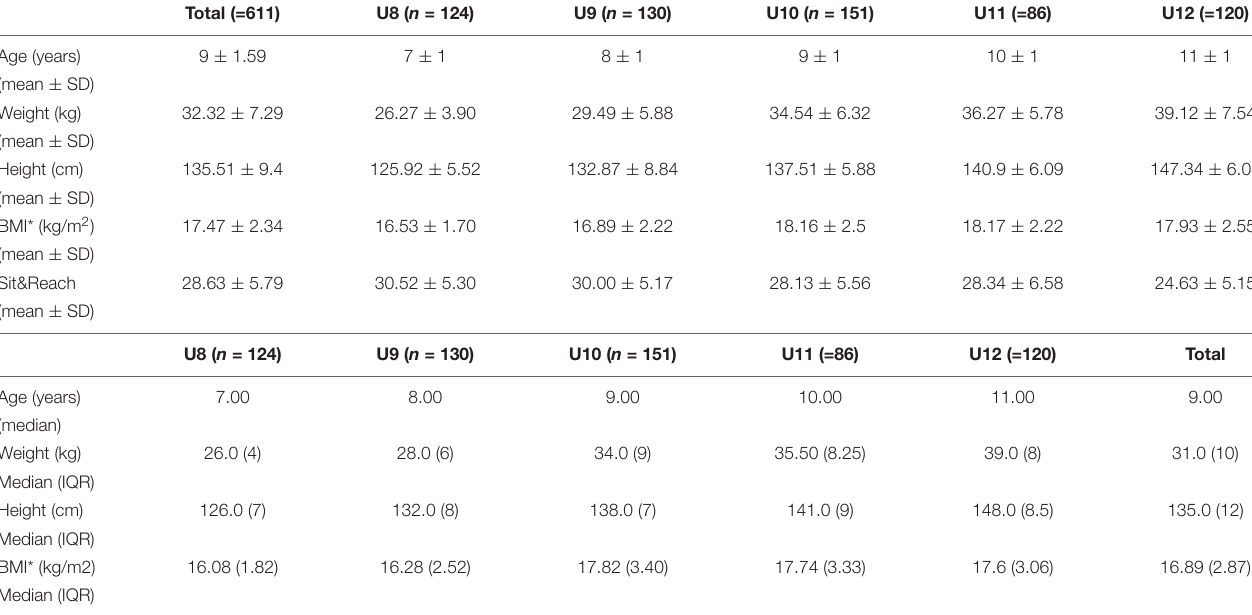
TABLE 1 | Participants characteristics.